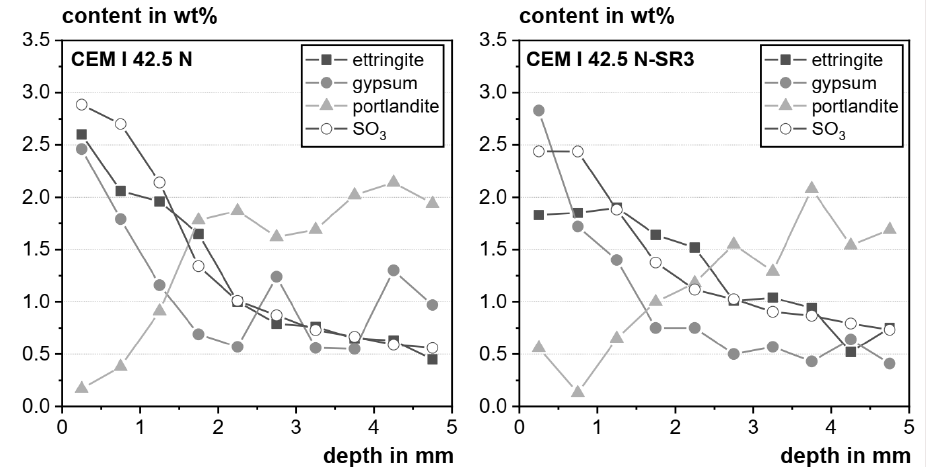
Figure 16. Ettringite, gypsum, portlandite content (XRD) and SO 3 content (carbon/sulfur analysis) over the depth of the specimen with CEM I 42.5 N and CEM I 42.5 N-SR3 (w/c = 0.50) stored for 182 d at 5 ◦ C in Na 2 SO 4 solution with 6000 mg SO 42 −